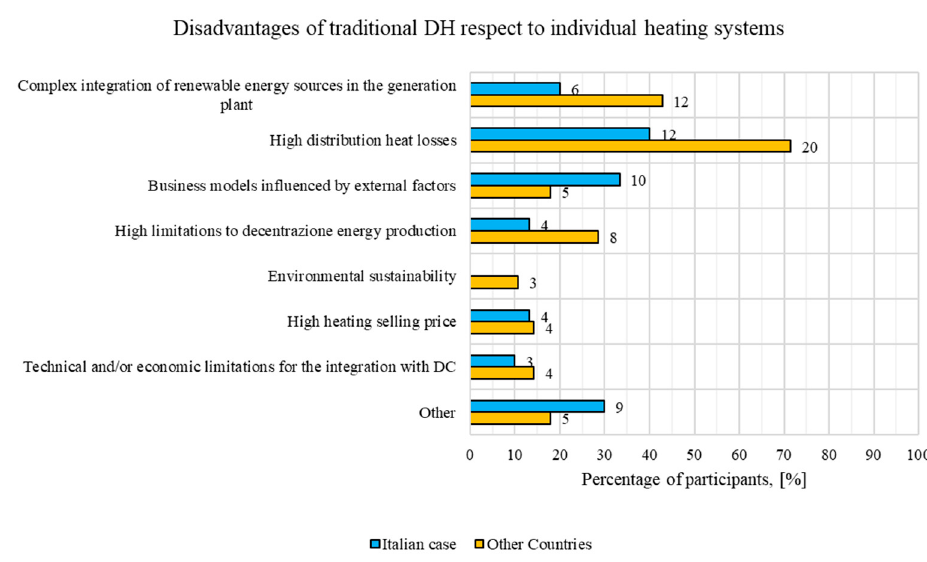
Figure 17. Disadvantages of traditional DH systems with respect to individual heating systems.